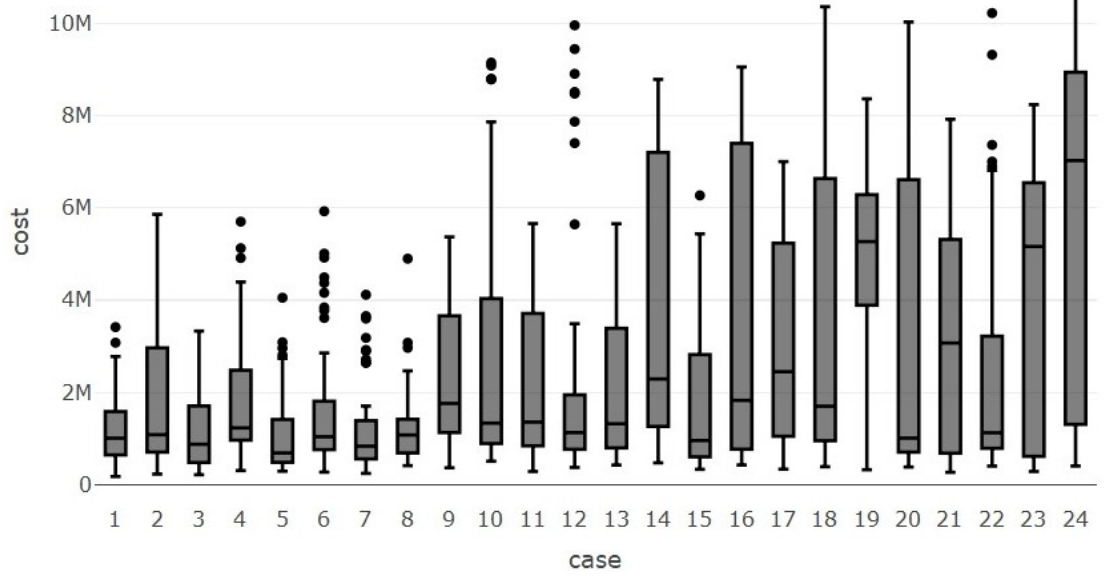
Figure 2. Distribution of the total cost for each case over 50 simulation instances.